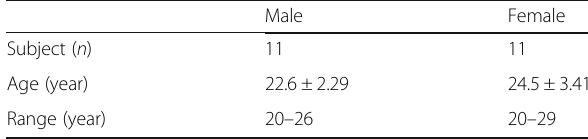
Table 1 Patient characteristics